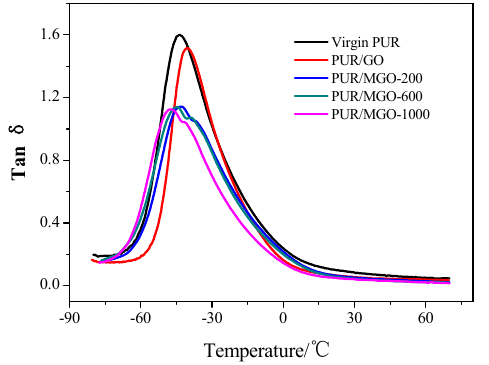
Figure 4. Dynamic mechanical properties of PUR, PUR/GO and PUR/MGO.